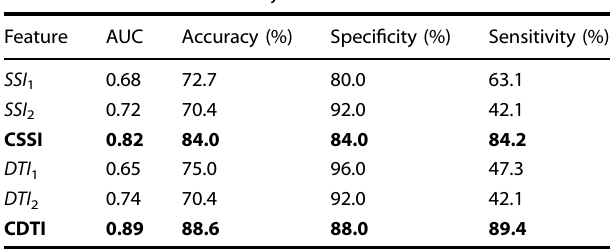
Fig. 4 Two-dimensional projection of all subjects over the indices. a Using the subsystem indices SSI 1 and SSI 2 , b using the dysarthria type indices DTI 1 and DTI 2 . The black line is the logistic regression boundary for the classi fi cation between PSP and MSA using all data. Table 2. Classi fi cation accuracy between PSP and MSA. Table 5. Correlations between speech and clinical motor